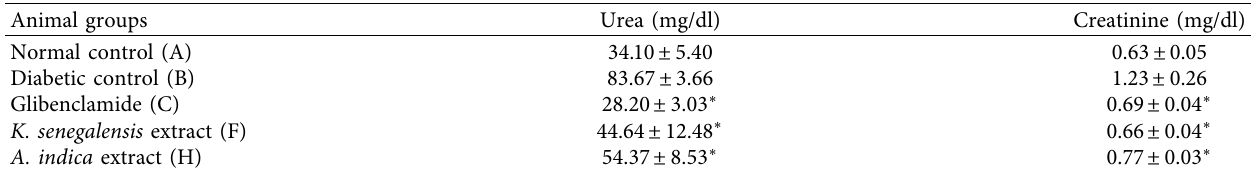
Table 4: Infuence of oral administration of K. senegalensis stem bark and A. indica leaf hydroethanolic extracts on kidney function markers in diabetic